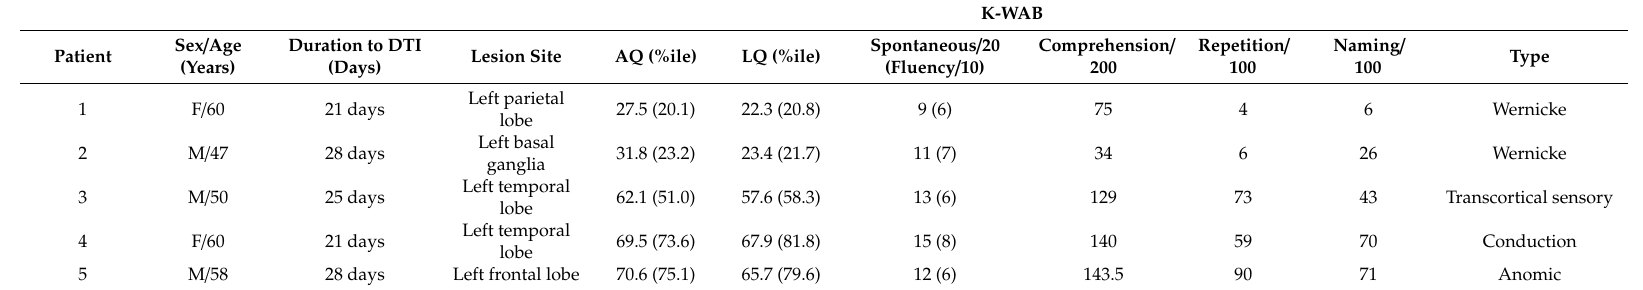
Table 1. Demographic data of patients and results of Korean-Western Aphasia Battery